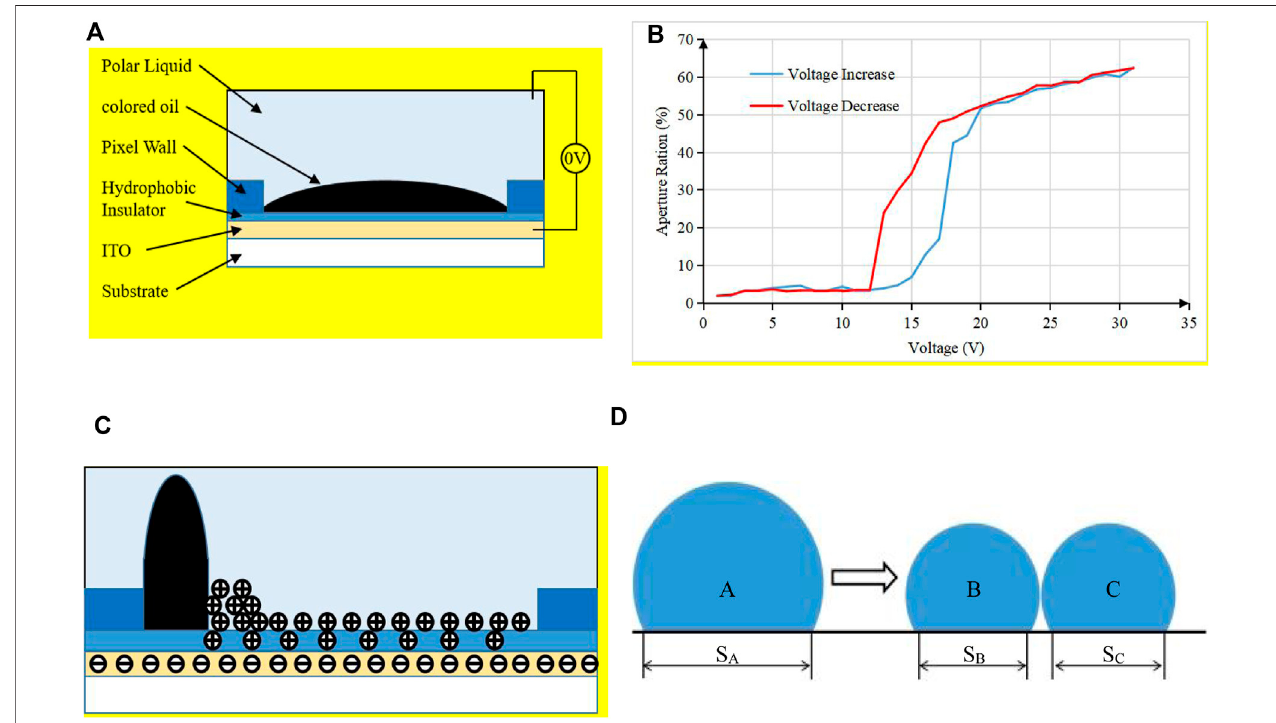
FIGURE1| ThestructureofanEWDpixelandthephenomenonofdefectsinEWDs. (A) Thewholepixeliscoveredwithoilandthecolorofoilisdisplayedwhenthe driving voltage is 0 V. (B) Phenomenon of contact angle hysteresis. The blue curve is the aperture ratio when the driving voltage is increased from 0 to 30 V, and the red curve is the aperture ratio when the driving voltage is decreased from 30 to 0 V. (C) Phenomenon of charge trapping. When the oil shrinks to one corner of a pixel, the charge distribution in a pixel. Charge trapping would be caused when the interaction between ions and hydrophobic insulating layer is stronger than that between ions and conductive liquid. (D) Phenomenon of oil splitting. A is the colored oil which shrinks to one corner of a pixel. B and C are oil which is split into two parts.